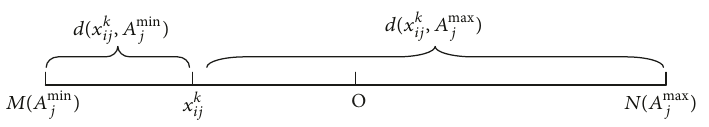
Figure 2: Distances ratio-based rating uncertain degree for 𝑥 𝑘 𝑖𝑗